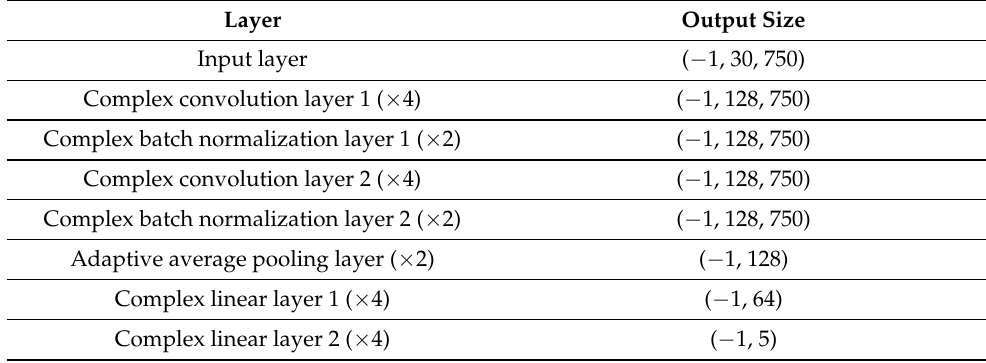
Table 1. The model structure of feature extraction